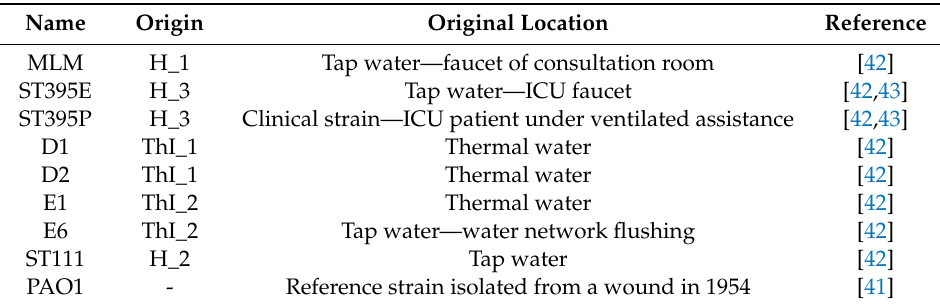
Table 1. Environnemental and clinical P. aeruginosa